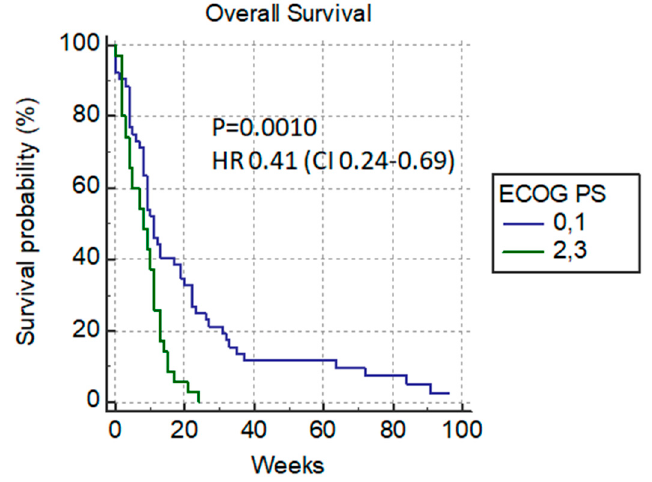
Figure 4. Overall survival versus ECOG status.